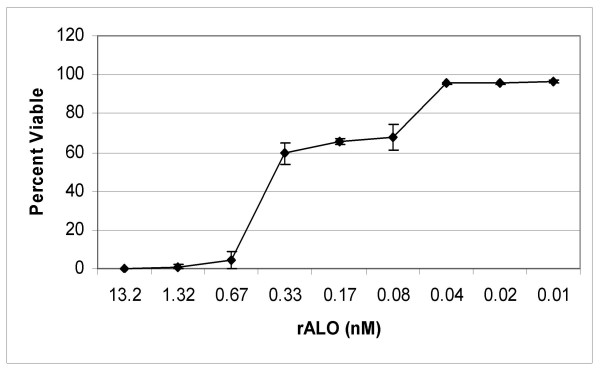
Recombinant ALO lyses human monocytic THP-1 cells in a dose-dependent manner. Percent viability of THP-1 monocytes measured by trypan blue after 30 min incubation with various concentrations of rALO in serum free conditions. Results show that 50% of THP-1s are lysed by 0.35 nM of rALO. The means and standard deviations of at least three independent experiments, each performed in duplicate, are shown (Spearman correlation is -0.870, p = 0.002).